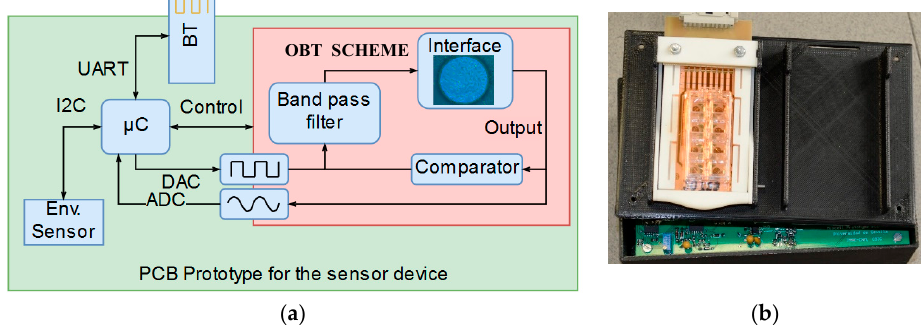
Figure 3. ( a ) The block diagram for the implemented PCB (Printed Circuit Board) prototype of the sensor device. Interdevice communication is performed by data buses; Universal Asynchronous Receiver-Transmitter (UART) and Inter-Integrated Circuit (I2C). The microcontroller ( µ C) implements Digital to Analog (DAC) and Analog to Digital (ADC) converters to trigger/acquire the Oscillation Based Test (OBT) sensor signal. ( b ) A photo of the sensor device.